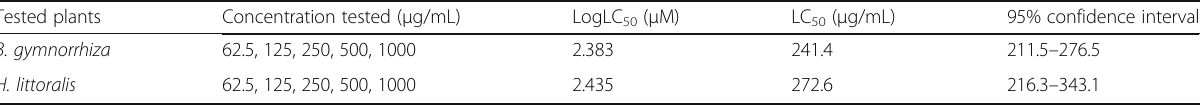
Table 4 Cytotoxic activity of methanol leaf extract of selected mangrove plant species on brine shrimp nauplii Tested